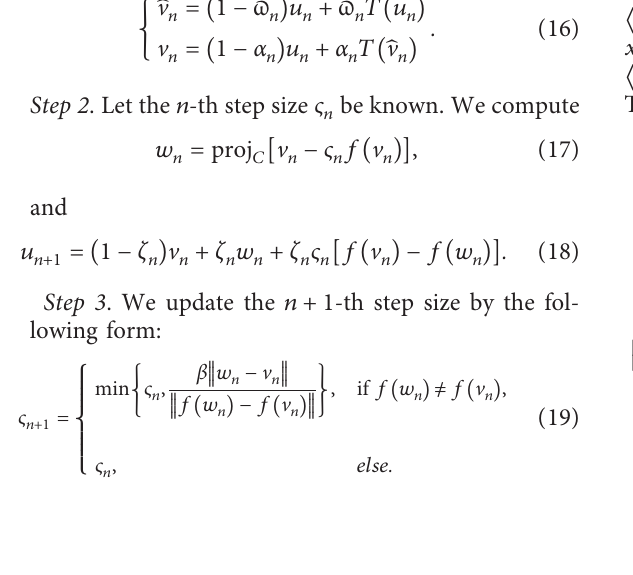
∈ H be an initial guess. We 0